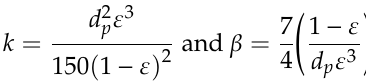
Figure 8. Prediction of porous medium friction factor as a function of porous medium Reynolds number. The data points are generated using the Forchheimer equation (Equation